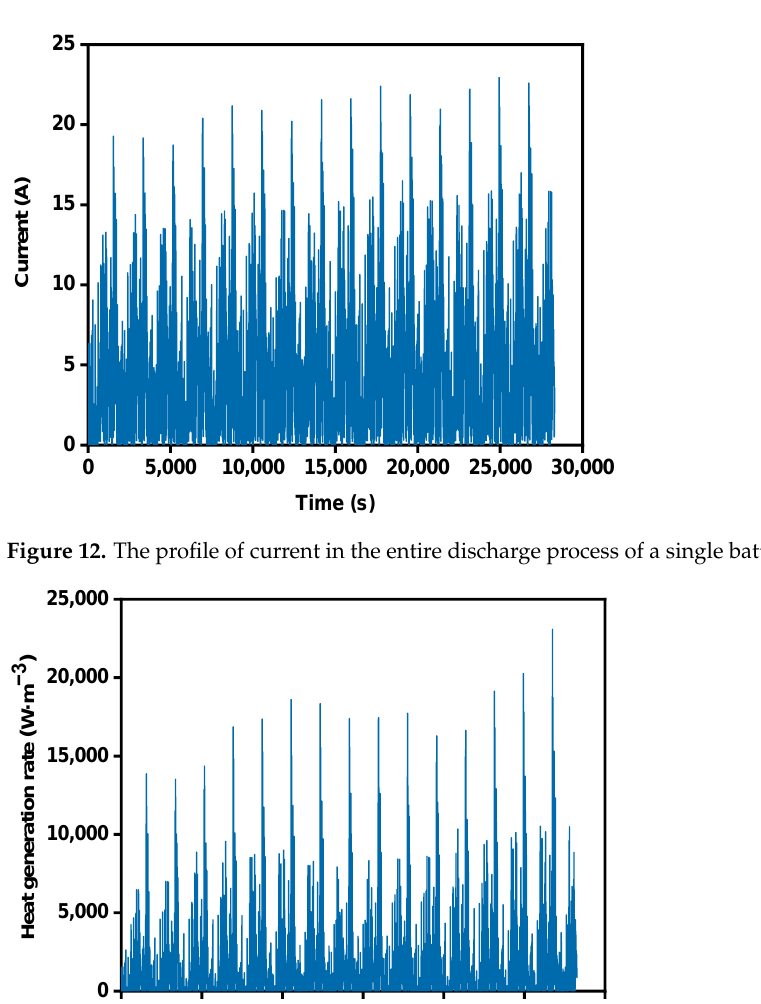
Figure 13. Heat generation rate of a single battery under 15.7 WLTCs.